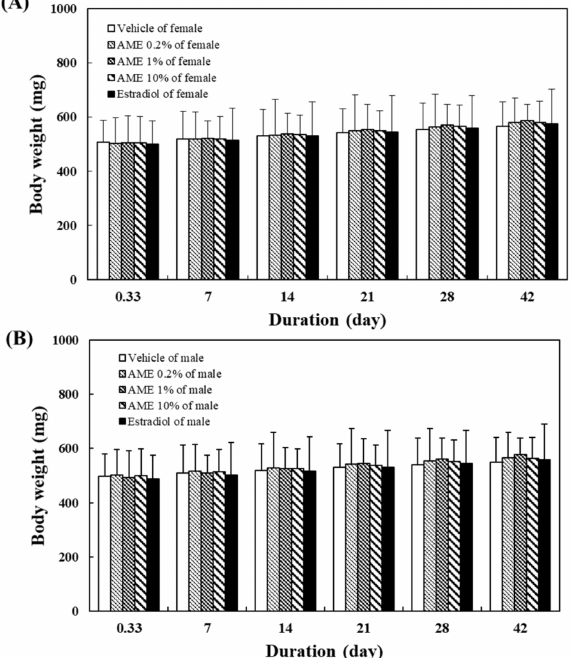
Figure 4. Effects of the supplementation with AME ( A : Female, B : Male) on the body weight of zebrafish during 42-day cultivation. At each sampling time, five male or female adult fish were